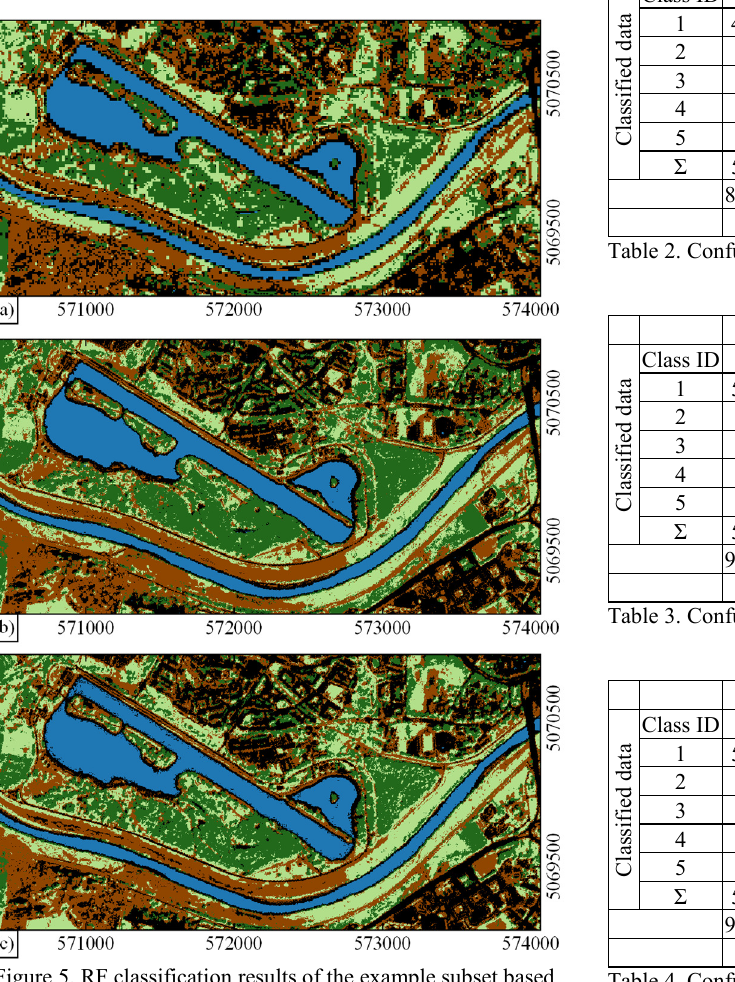
Figure 4. “True-colour” composite of the example subset based on the: (a) S-2 (4–3–2) and (b) fused imagery (3–2–1)